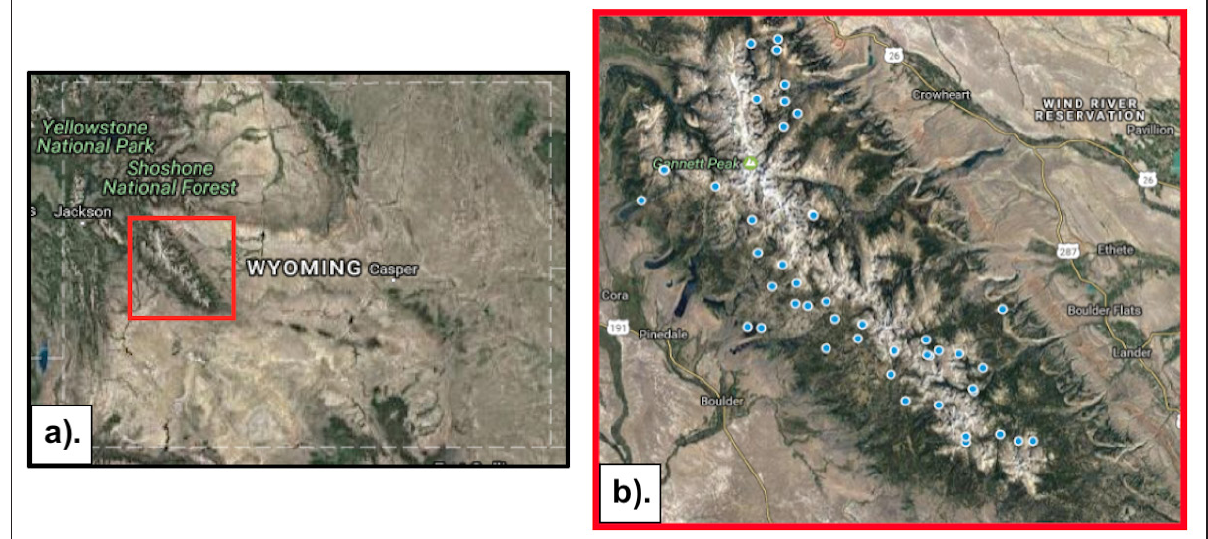
Figure 1: The Wind River Mountains are located in western Wyoming (a) , and the first season of the Clark’s Nutcracker Project resulted in 54 occupancy surveys distributed across the study area (b) . Images from Google MyMaps: https://